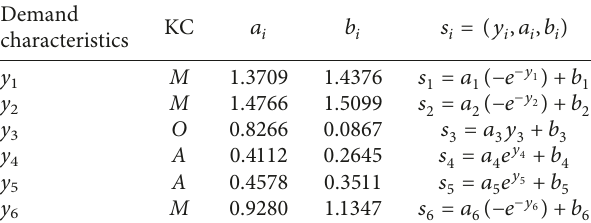
Table 4: Adjustment coefficient and satisfaction